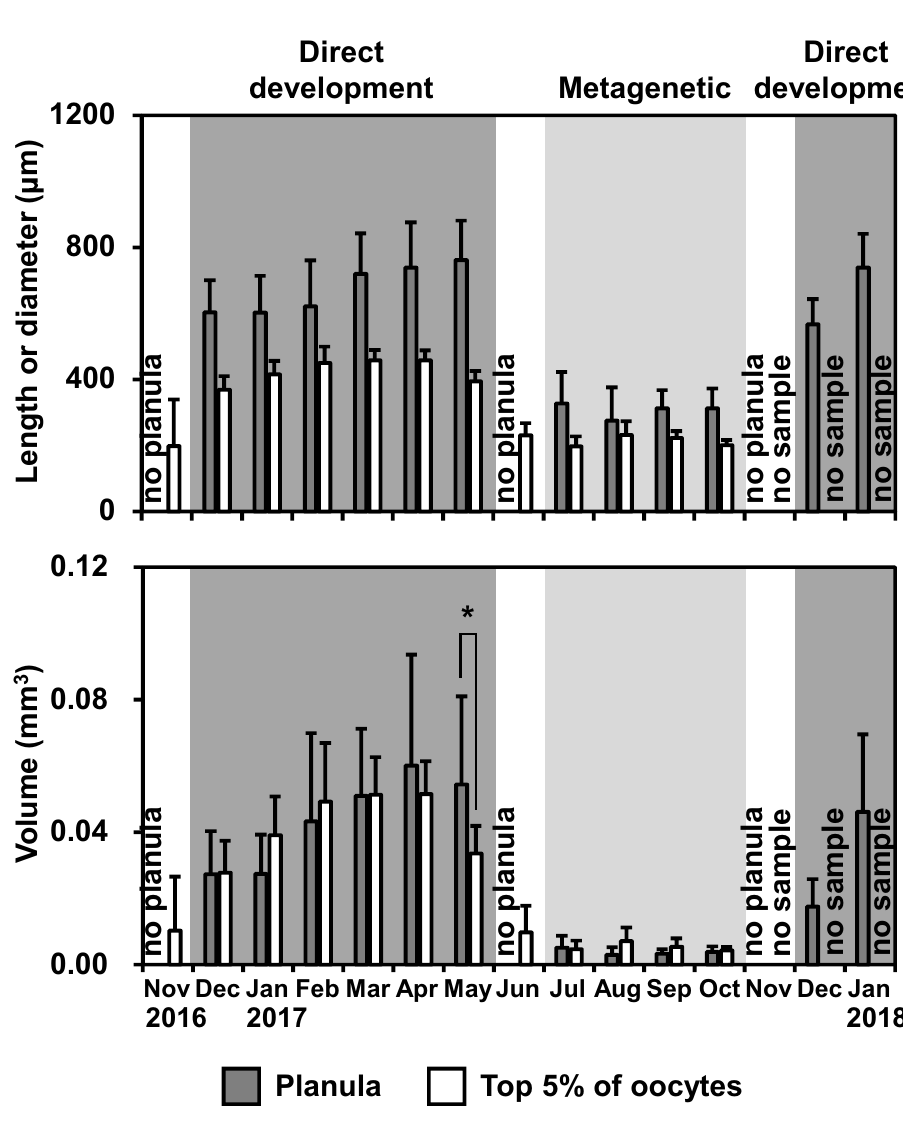
Fig 9. Temporal variations in the length of the major axis of the planulae, diameter of the top 5% of oocytes, and volume of the planulae and top 5% of oocytes. Bars and error bars are mean values and SD. � in the bottom figure indicates a significant difference ( P < 0.05). No planula indicates that no females bore planulae. Dark and light shades indicate the direct-development and metagenetic periods, respectively.